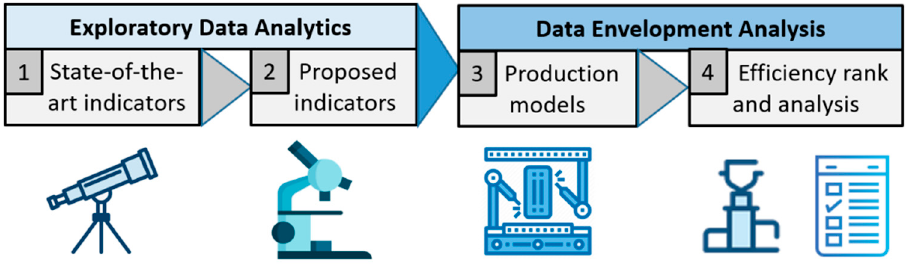
Figure 1. Overview of the proposed methodology.